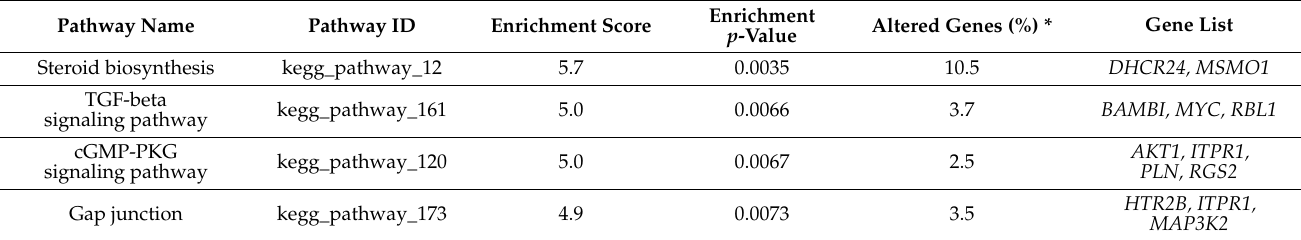
Table 3. Enrichment analysis of pathways for downregulated genes in vitrified blastocysts.